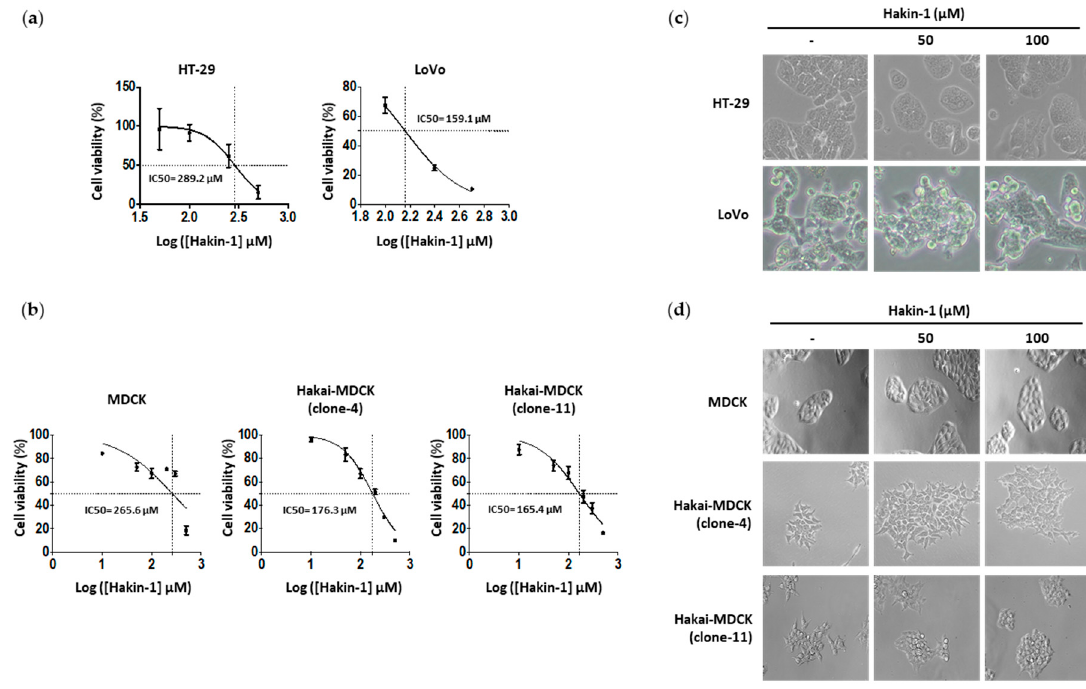
Figure 2. Hakin-1 induces cytotoxicity and an epithelial phenotype on epithelial tumour cell lines. ( a ) HT-29 and LoVo cells were treated with an increasing range of concentrations of Hakin-1 and cell viability was measured by means of the MTT assay (3-(4,5-dimethylthiazol-2-yl)-2,5-diphenyltetrazolium bromide). This assay was performed in six replicates and represented as mean ± SD of three independent experiments. ( b ) Cell viability was measured as indicated in panel ( a ), for MDCK and Hakai-MDCK cell lines (clone 4 and clone 11) using Hakin-1. ( c-d ) Phase-contrast images of HT-29 and LoVo cell lines ( c ) and MDCK, Hakai-MDCK cell lines, clone 4 and clone 11 ( d ) under Hakin-1 treatment. Images were obtained using a 20× objective.